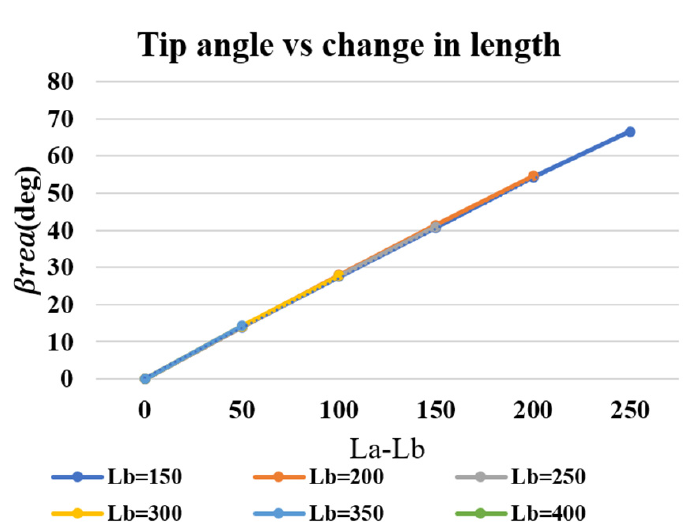
Figure 5. Tip angle vs. change in